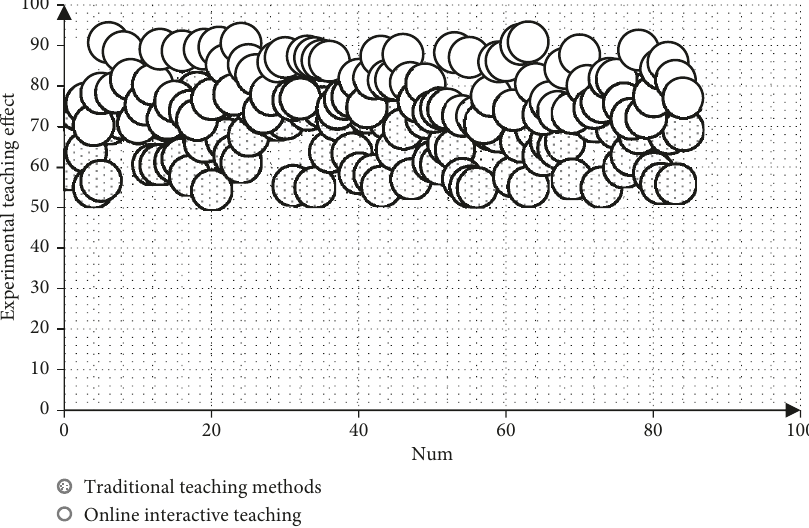
Figure 10: Statistical diagram of teaching experiment data.